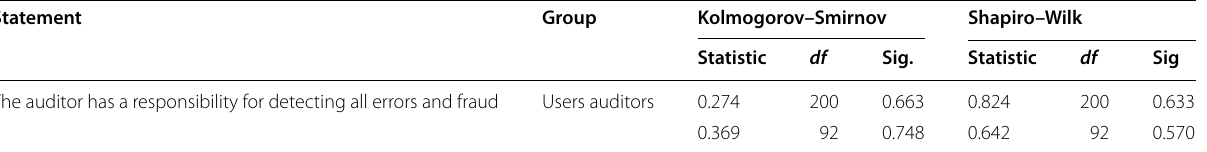
Table 7 Test of the distribution normality. Source: Survey Data Analysis (2019)